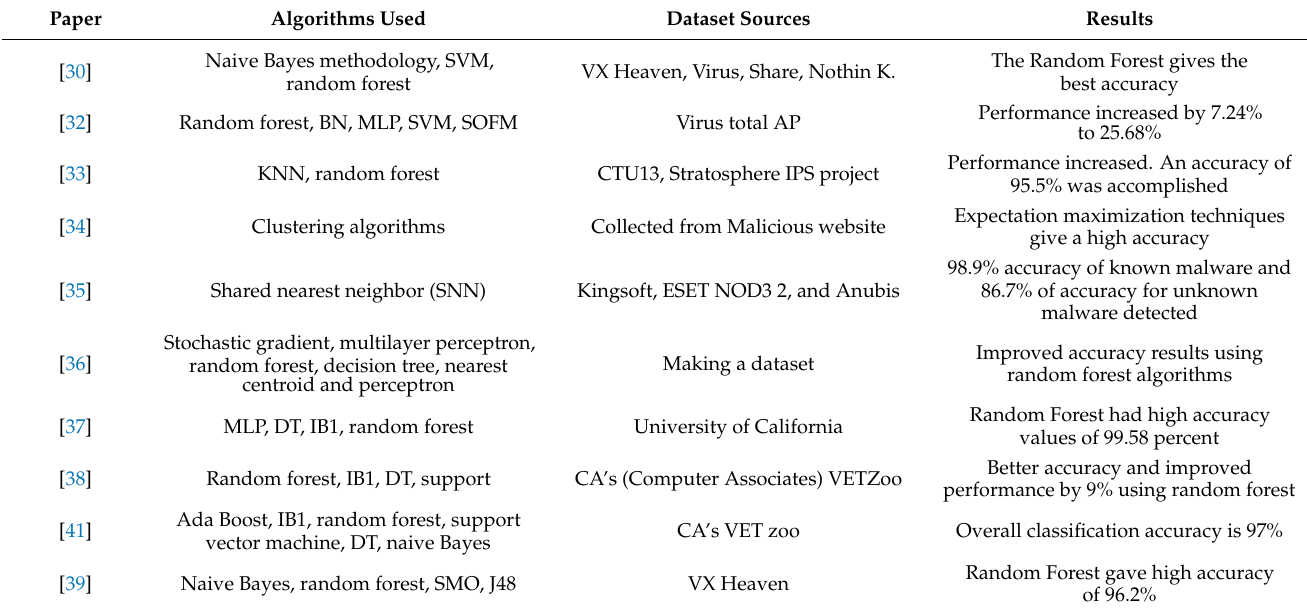
Table 2. Overview of existing techniques.